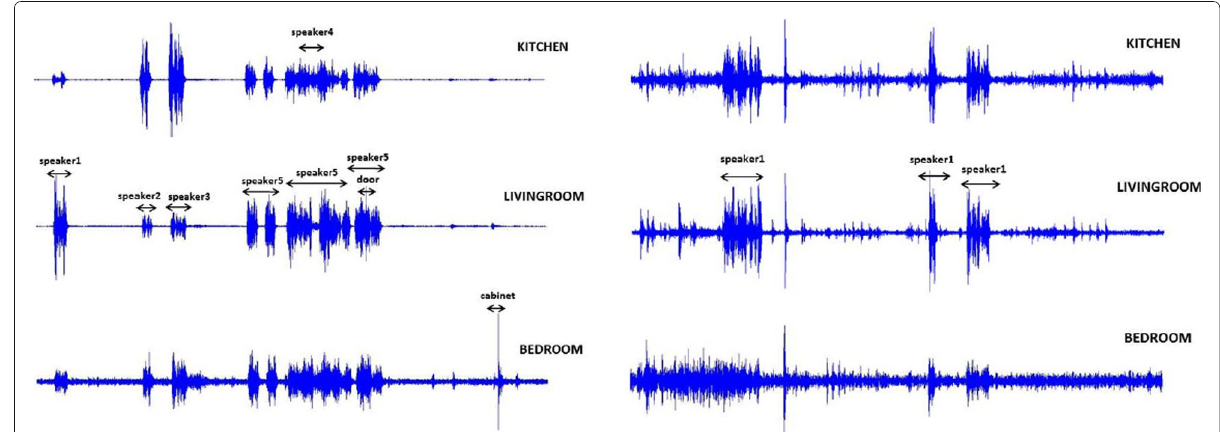
Fig. 1. In traditional SAD, the aim is to detect speech anywhere in the smart home, and as a result, each test- set sequence is evaluated only once (75 sequences for DIRHA-sim and 60 for DIRHA-real). In contrast, in the room-localized case, for each sequence, a total of R